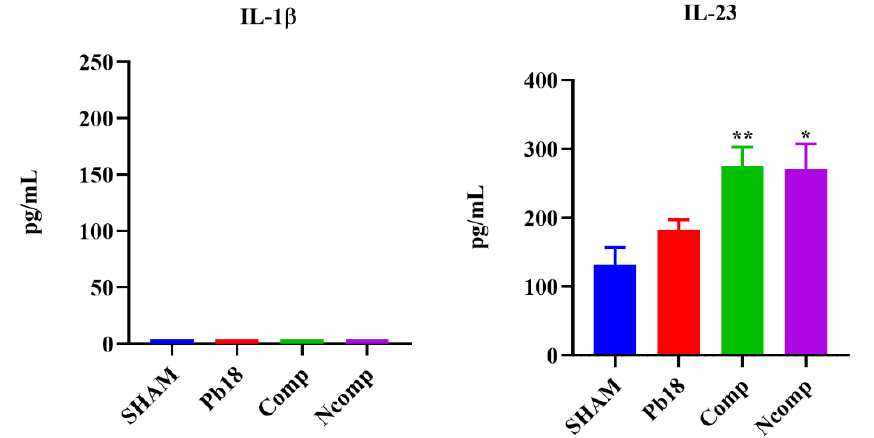
Figure 8. Th17-induced cytokine production 51 days post infection. No changes in IL-1 β levels were detected, but IL-23 was significantly increased for both nanoparticles treatment groups when compared to the Pb18 group. SHAM (non-infected and non-treated), Pb18 (infected and non-treated), Comp (infected and treated with the P10 complexed nanoparticles) and Ncomp (infected and treated with the P10 co-administered with empty nanoparticles). * = p < 0.05 and ** = p < 0.01.